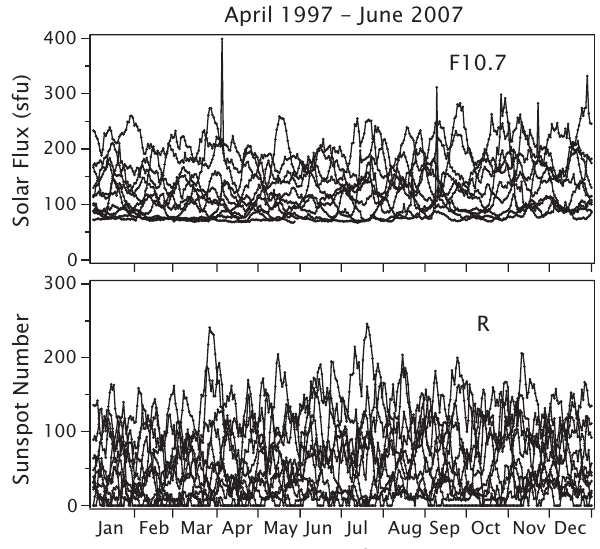
Fig. 3. Seasonal distribution of observed daily solar flux (upper panel) and daily sunspot number (lower panel) from April 1997 to June 2007.